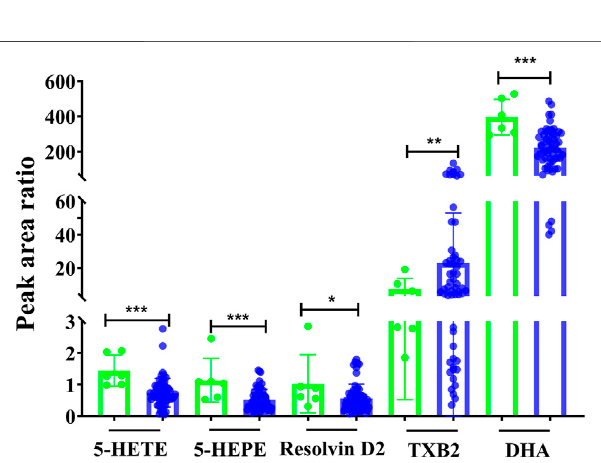
FIGURE 4 | Metabolic peak area ratio comparation between the pre- dose and post-dose. * p < 0.05, *** p < 0.001, and two-tailed unpaired t-test.